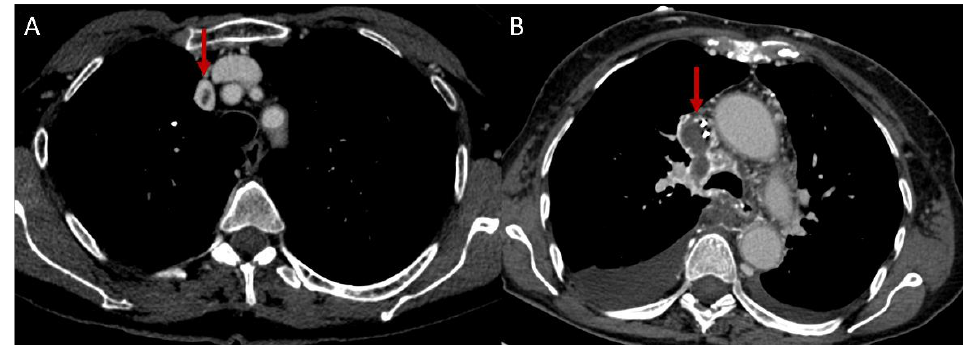
Figure 5. SVC thrombosis (red arrows): ( A ) minimum SVC thrombosis in BD patient; ( B ) SVC and azygos vein thrombosis in BD patient with CVC.